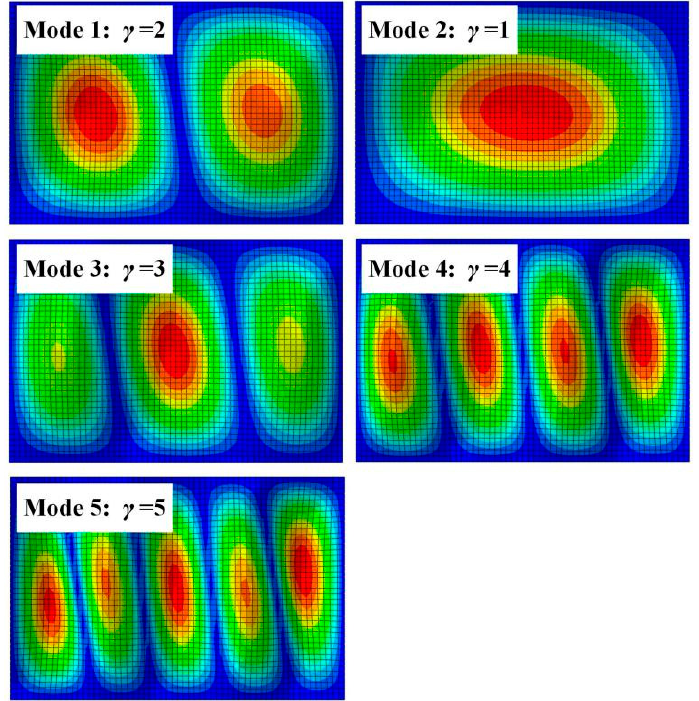
Figure 3. The first five buckling modes for the composite plate.